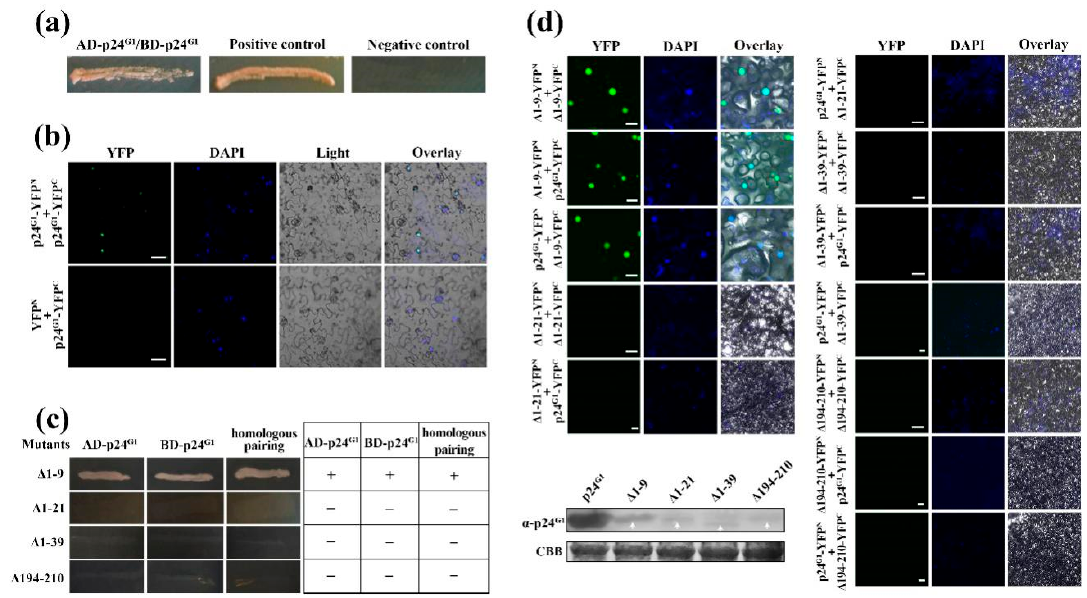
Figure 3. Functional region responsible for self-interaction of p24 of grapevine leafroll-associated virus 1 (p24 G1 ). ( a , b ) p24 G1 self-interacts in yeast ( a ) and plant ( b ) cells. Yeast strain AH109 cells coexpressing AD–p24 G1 and BD–p24 G1 were plated on SD / -Leu-Trp-His-Ade plates. Pairs of pGBKT7 / pGAD–p24 G1 and pGBKT7–53 / pGADT7–RecT (provide by the kit) served as negative and positive controls, respectively. p24 G1 –YFP N / p24 G1 –YFP C were coexpressed in N. benthamian a leaves. Coexpression of YFP N / p24 G1 –YFP C served as the negative control. Bars = 50 µ m. ( c , d ) Analyses of self-interaction of p24 G1 mutants as well as the interaction between mutants and wt p24 G1 in yeast ( c ) and plant ( d ) cells. The indicated mutants were fused to GAL4 AD and BD, respectively ( c ). A summary of interaction results in yeast is indicated in the table. + , interaction; − , no interaction. Bars = 100 µ m (scale bars in the images marked with “ ∆ 1–9” are 20 µ m). The expression of wt p24 G1 and mutants fused to the YFP N in plant cells at 3 dpi was monitored by Western blot as indicated in the lower left panel. CBB staining served as a loading control. Nuclei of tobacco leaf epidermal cells were stained with DAPI ( b , d ).